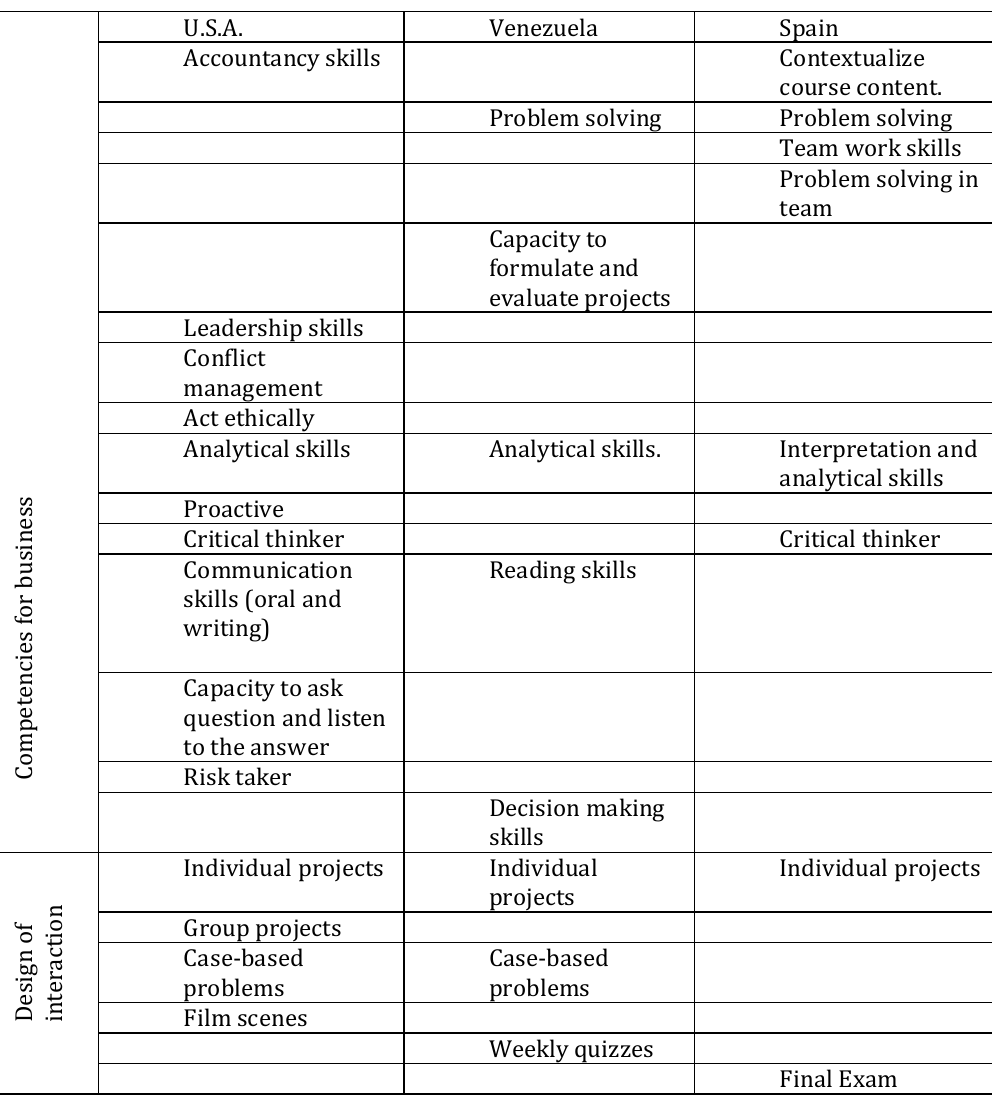
Competencies and Design of Interaction for Business Across Three